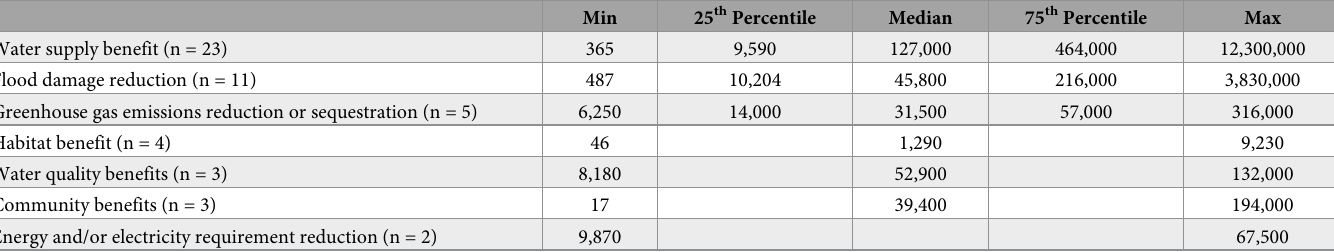
Table 3. Reported economic value of benefits in dollars per year for urban stormwater capture projects that reported at least one monetized